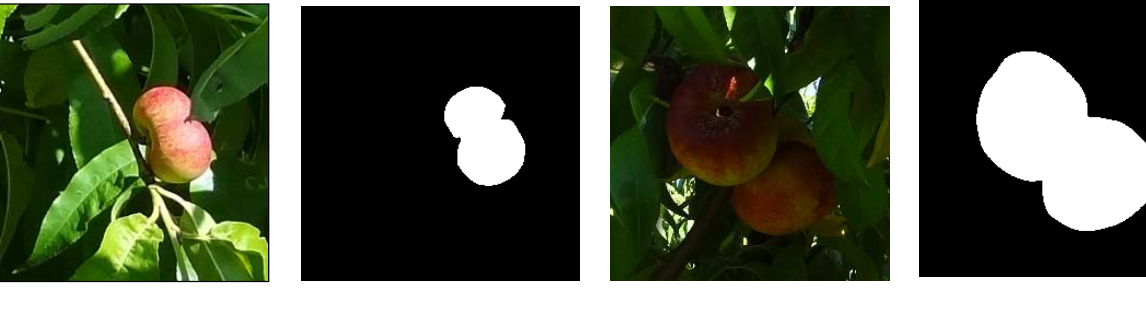
Figure 6. Sample original and segmented images of one ( left ) and two pieces of fruit ( right